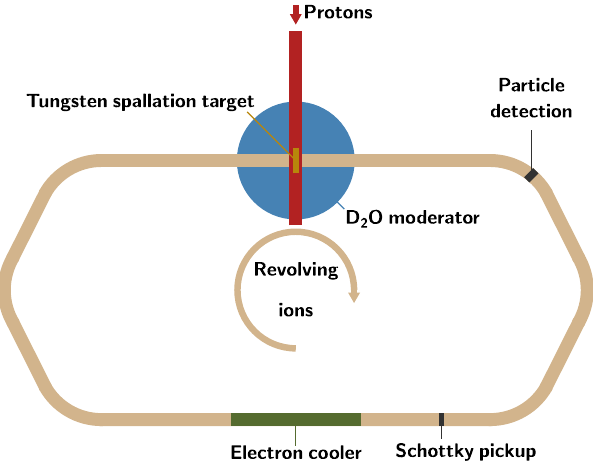
FIG. 1. Rough sketch of the proposed setup. Neutrons are produced by protons impinging on a tungsten spallation target (brown). The proton beam pipe (red) is orientated perpendicular to the ion beam pipe (light brown). The beam pipes do not intersect. The neutrons produced in the spallation process are moderated in the surrounding heavy water (blue). They penetrate the ion beam pipe and act as a neutron target for the ions. The ion beam pipe is part of a storage ring outside the moderator. The storage ring may contain additional equipment like an electron cooler (green), Schottky pickups and particle detectors